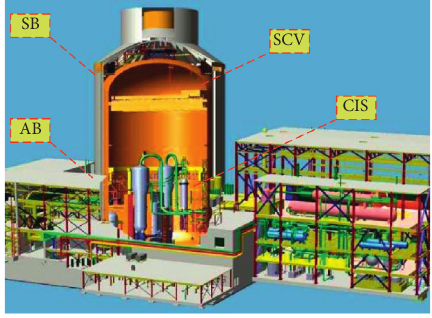
Figure 1: Diagram of the nuclear island